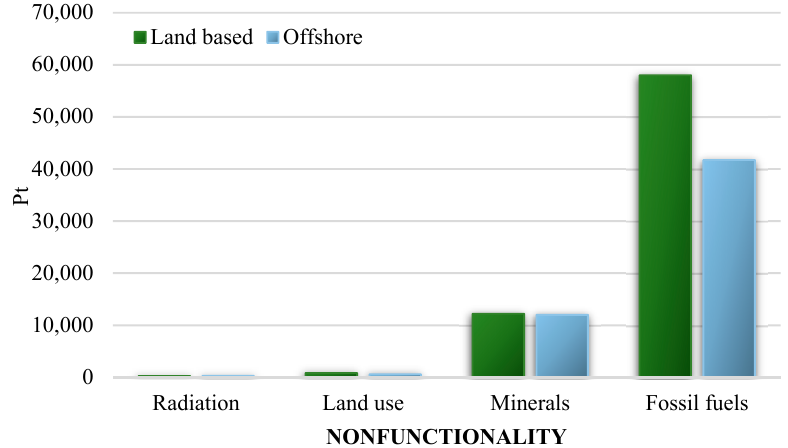
Figure 4. Results of grouping and weighing environmental impacts for nonfunctional impacts involved in life cycles of land-based and offshore wind power plant. Authors’ own research.